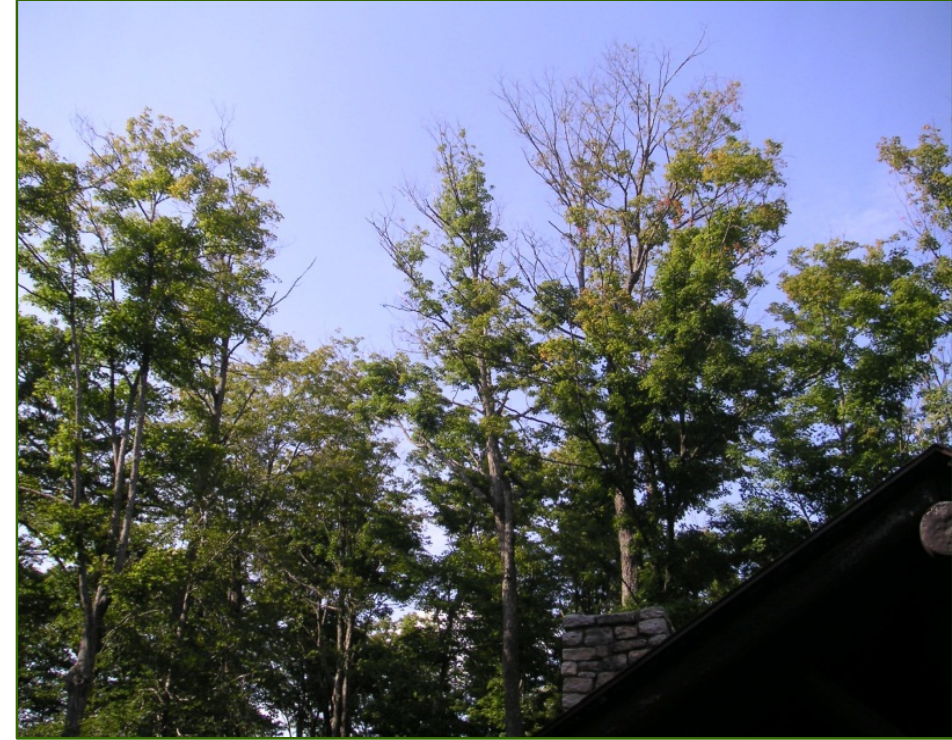
Figure 5. Sugar maple trees showing signs of stress, Allegheny Plateau, Pennsylvania (Photo: D. Fernando 2013).